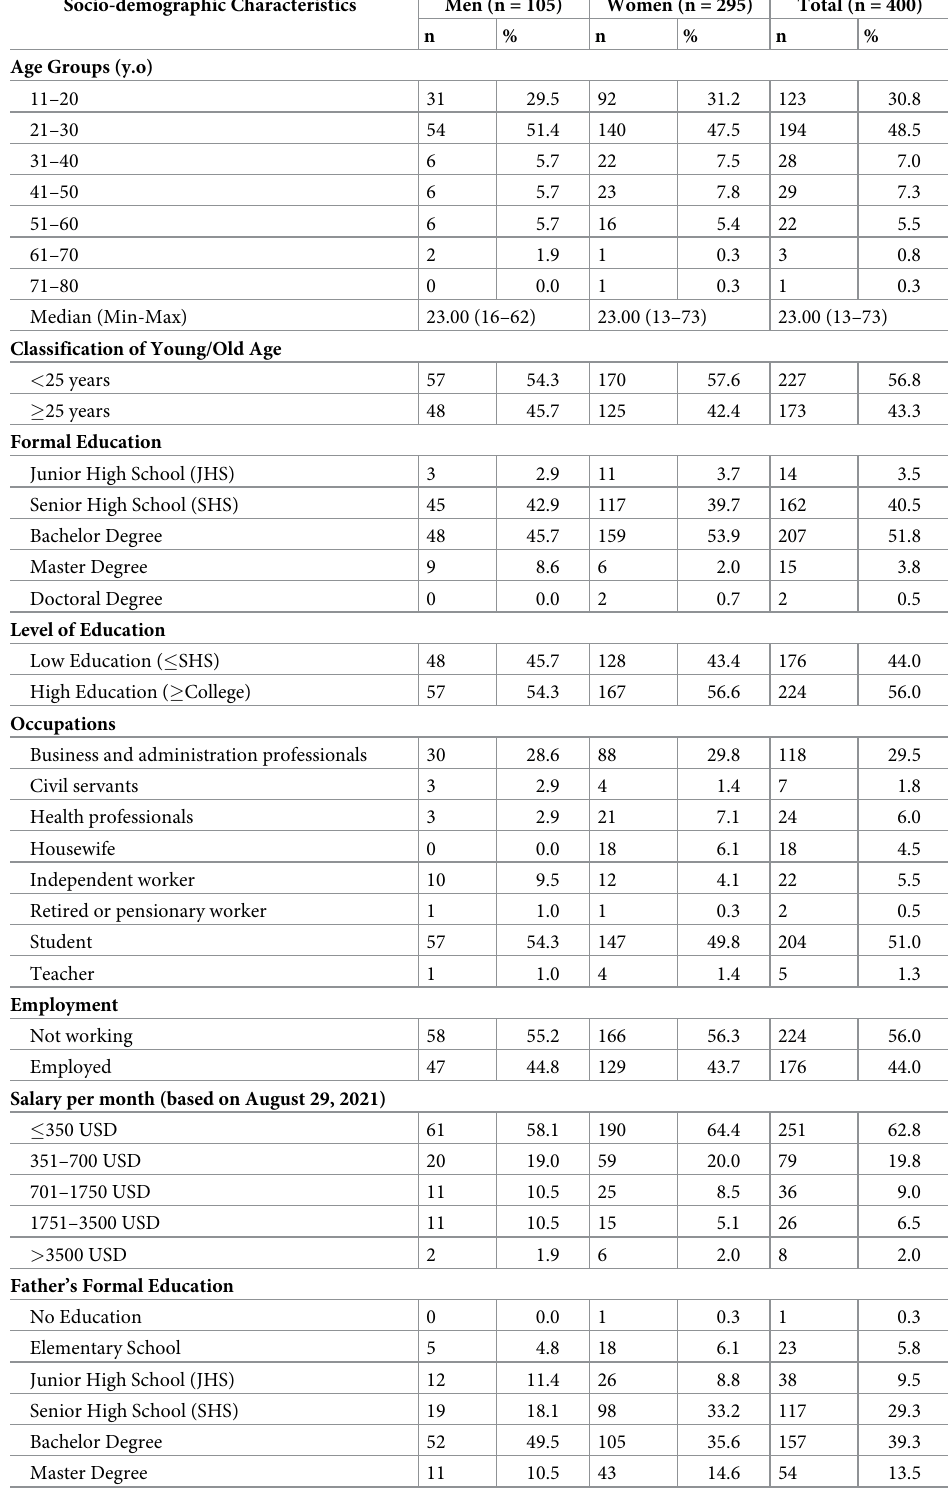
Table 1. Socio-demographical characteristics of 400 respondents in Jakarta, Indonesia